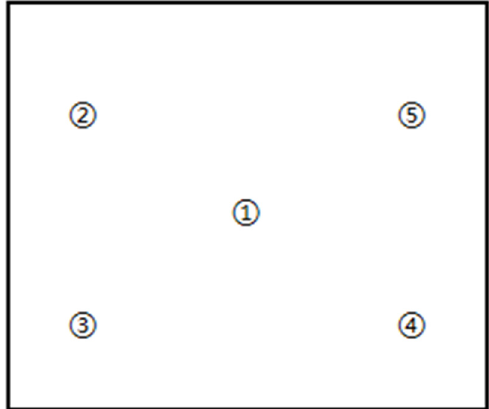
Figure 1. Location of temperature measurement and materials sampling of bedding. 1–5 respec- tively represent the 5 locations of each bedding